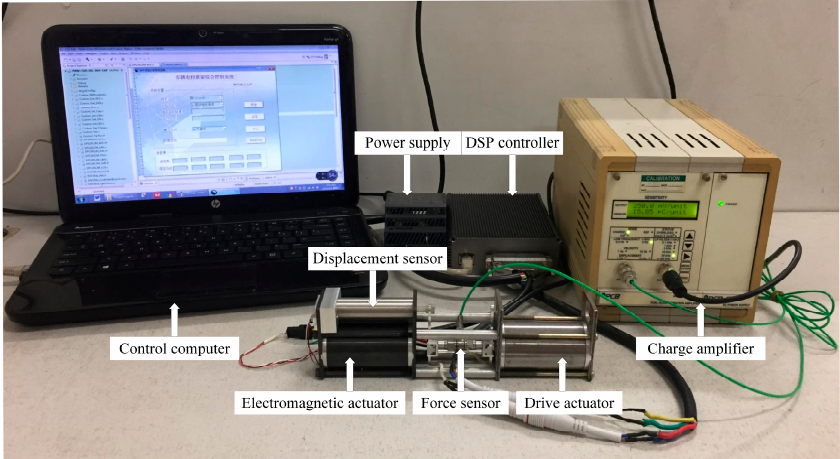
Figure 14. The test platform of the electric load simulator.